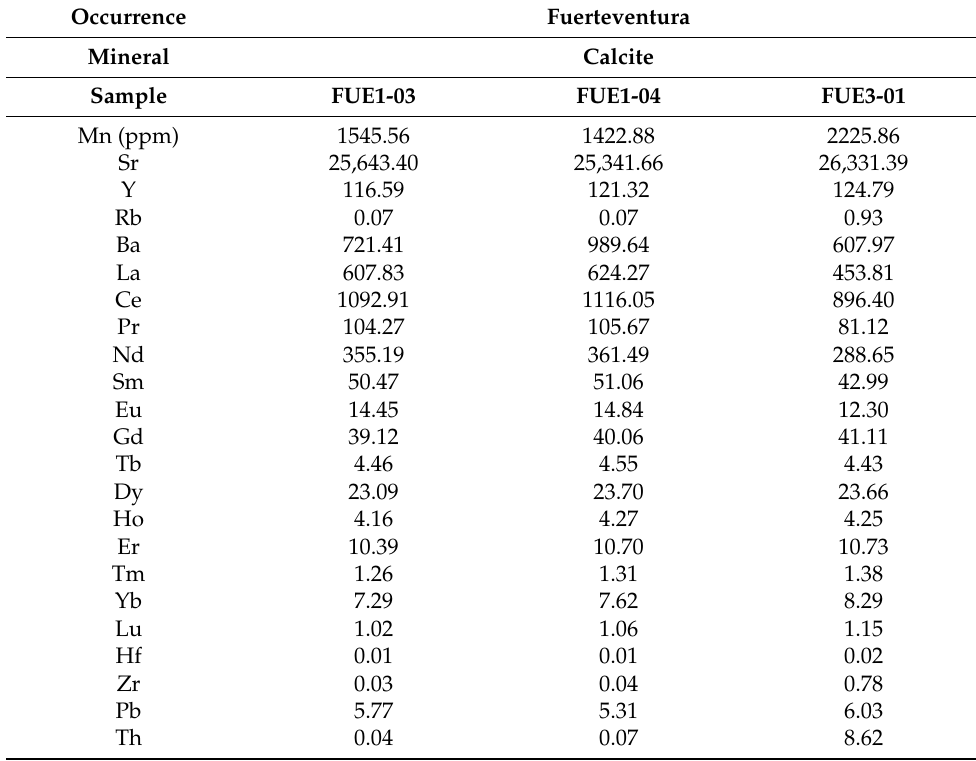
Table 2. Representative trace element compositions of calcite and apatite in Fuerteventura